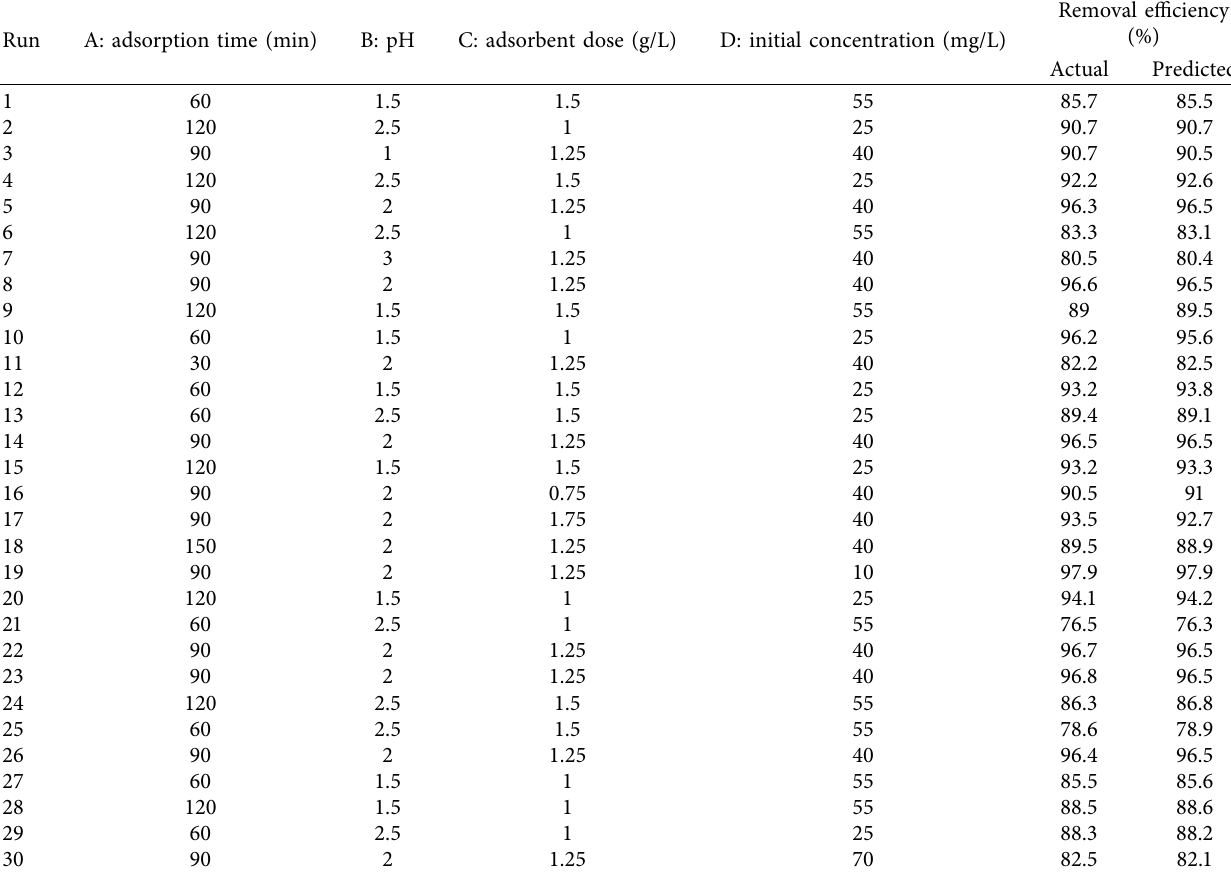
Table 4: Experimental design matrix generated by RSM-CCD for Cr(VI) ions removal using the nanocomposite adsorbent.